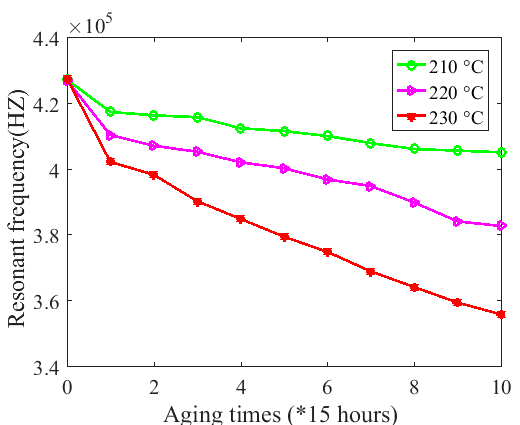
Figure 17. Relationship between resonant frequency and aging time under 210 °C, 220 °C, and 230 °C.